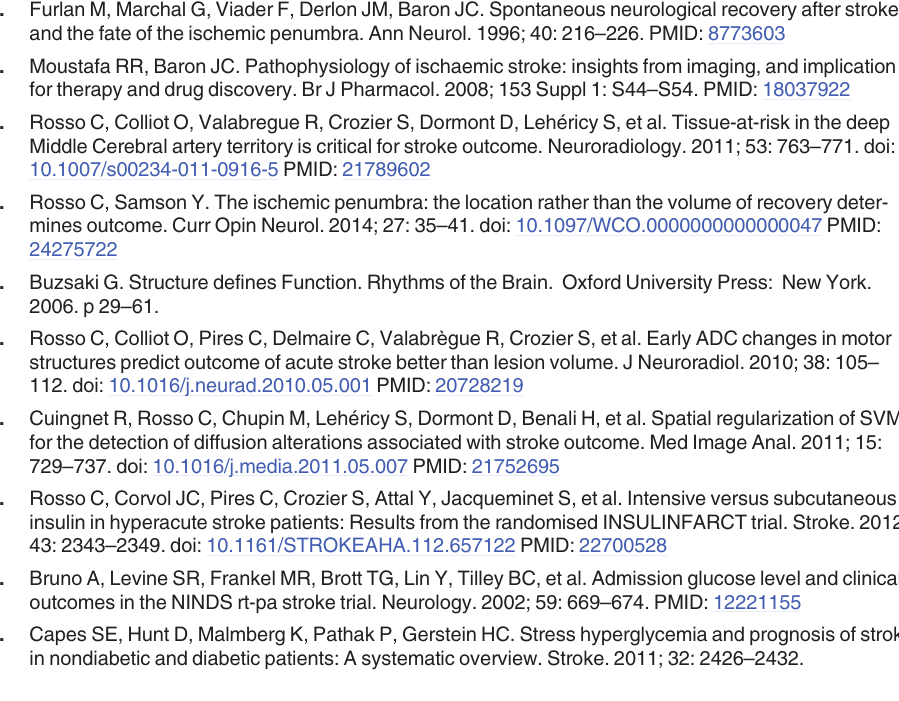
S1 Table. Characteristics of the intention-to-treat population in the INSULINFARCT trial, of the included and excluded population for this study. (DOC) S1 Fig. Mean Apparent Diffusion Coefficient values in the clinically relevant penumbra in hyperglycaemic and normoglycaemic patients. Dark grey represents recanalized patients and white bars non-recanalized patients. Bars represent mean; error bars represent 95% confidence interval of the mean.